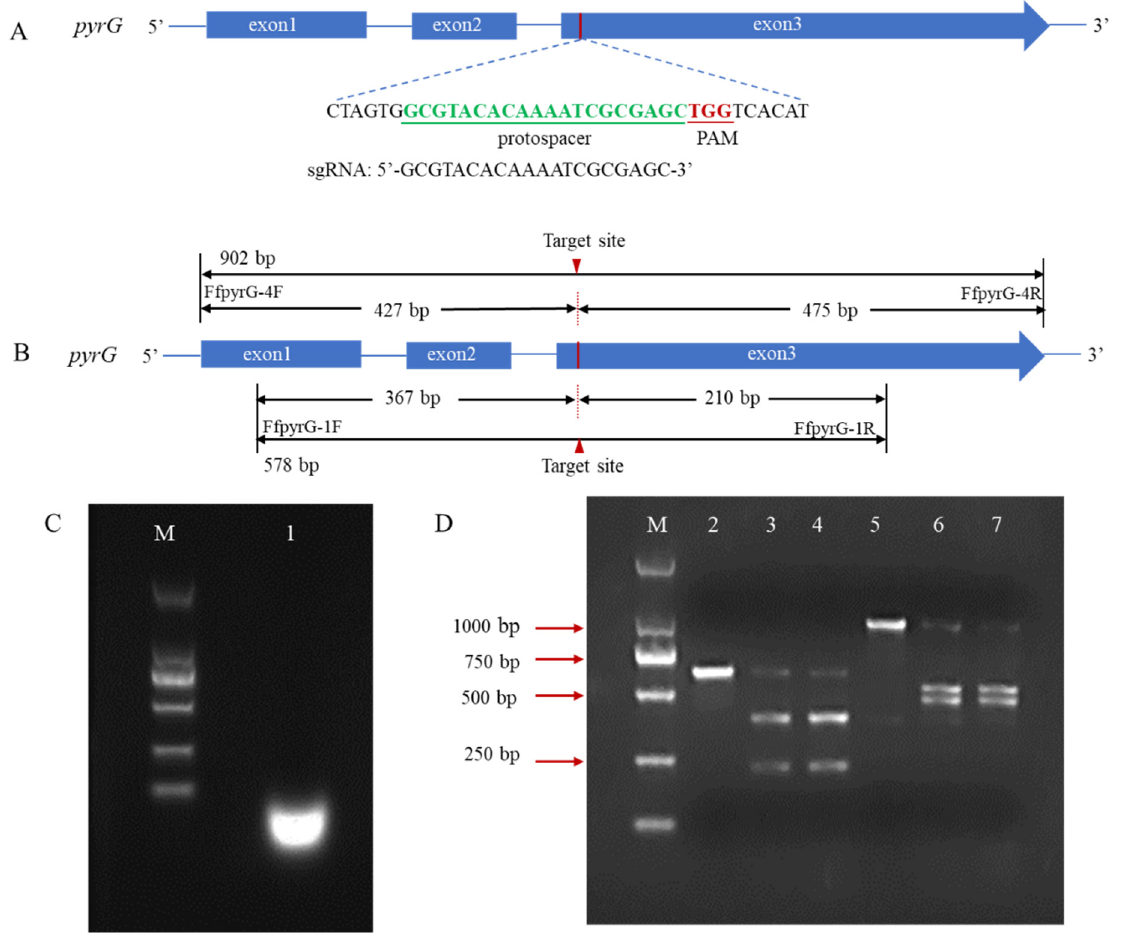
Figure 2. Schematic illustration of sequence information and in vitro Cas9 cleavage assay. ( A ) Se- quences of the sgRNA targeting pyrG are shown in green font, which were located at exon3. Sequence direction was 5 ′ -3 ′ as shown. Schematic representations of exons are drawn to scale. The protospacer adjacent motif (PAM) is shown in red. ( B ) Fragments required for the in vitro Cas9 cleavage assay were amplified with primers FfpyrG-1F/FfpyrG-1R and FfpyrG-4F/FfpyrG-4R. The red triangle represents the cleavage site of Cas9. The annealed products of crRNA and tracrRNA ( C ) and cleavage assay of Cas9 nuclease in vitro were visualized using agarose gel electrophoresis ( D ) M, DL 2000 marker; 1, sgRNA products; 2, pyrG-578 bp without RNPs; 3–4, pyrG-578 bp with RNPs; 5, pyrG-902 bp without RNPs; 6–7, pyrG-902 bp with RNPs.